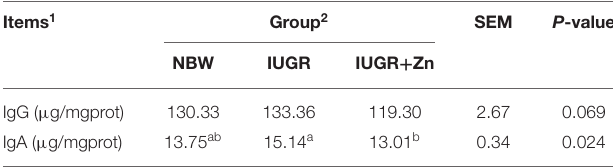
TABLE 4 | Effects of dietary Nano-ZnO supplementation on serum hormones parameters and immune status of the IUGR finishing pigs. Items 1